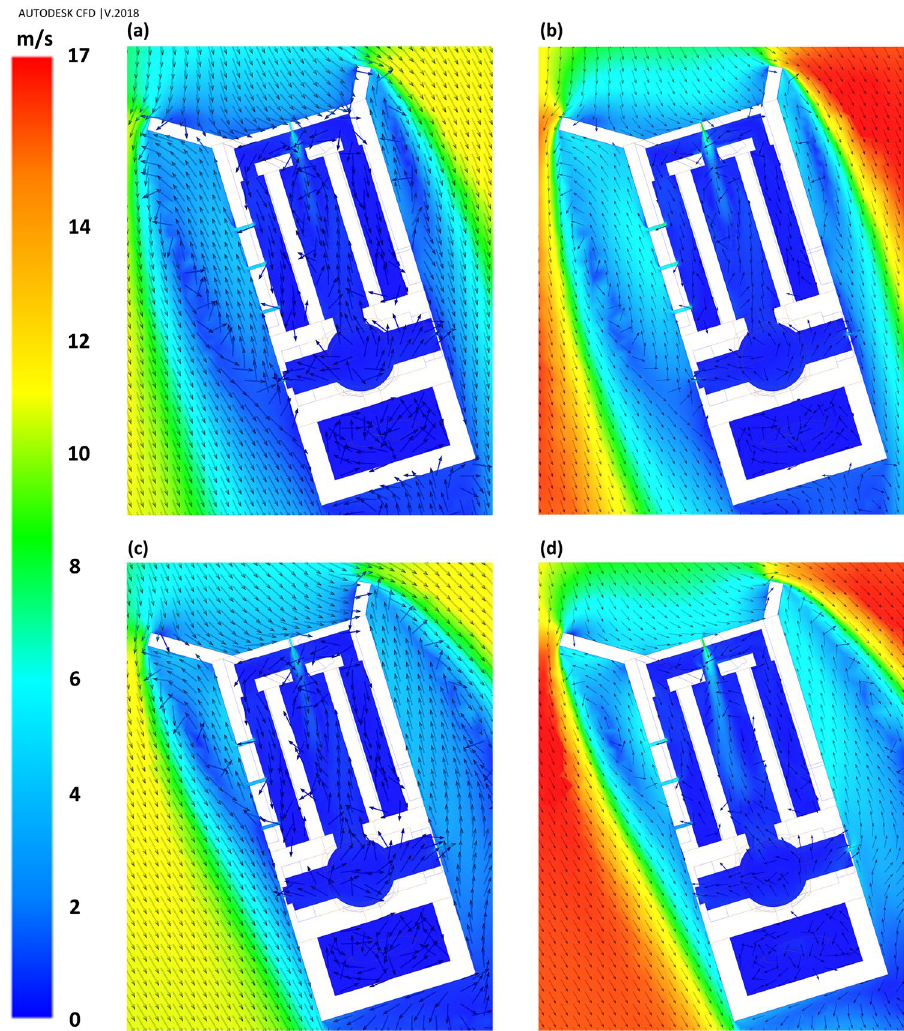
Figure 12. Flow pattern around the building in different scenarios: ( a ) Sc17-10, ( b ) Sc17-15, ( c ) Sc30-10, and ( d ) Sc30-15.